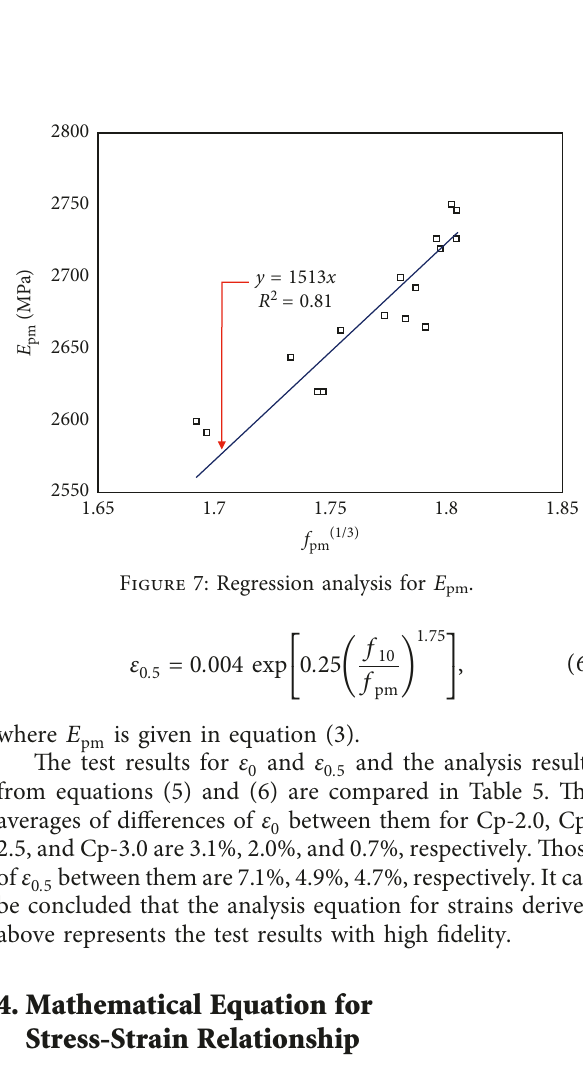
Figure 7: Regression analysis for E